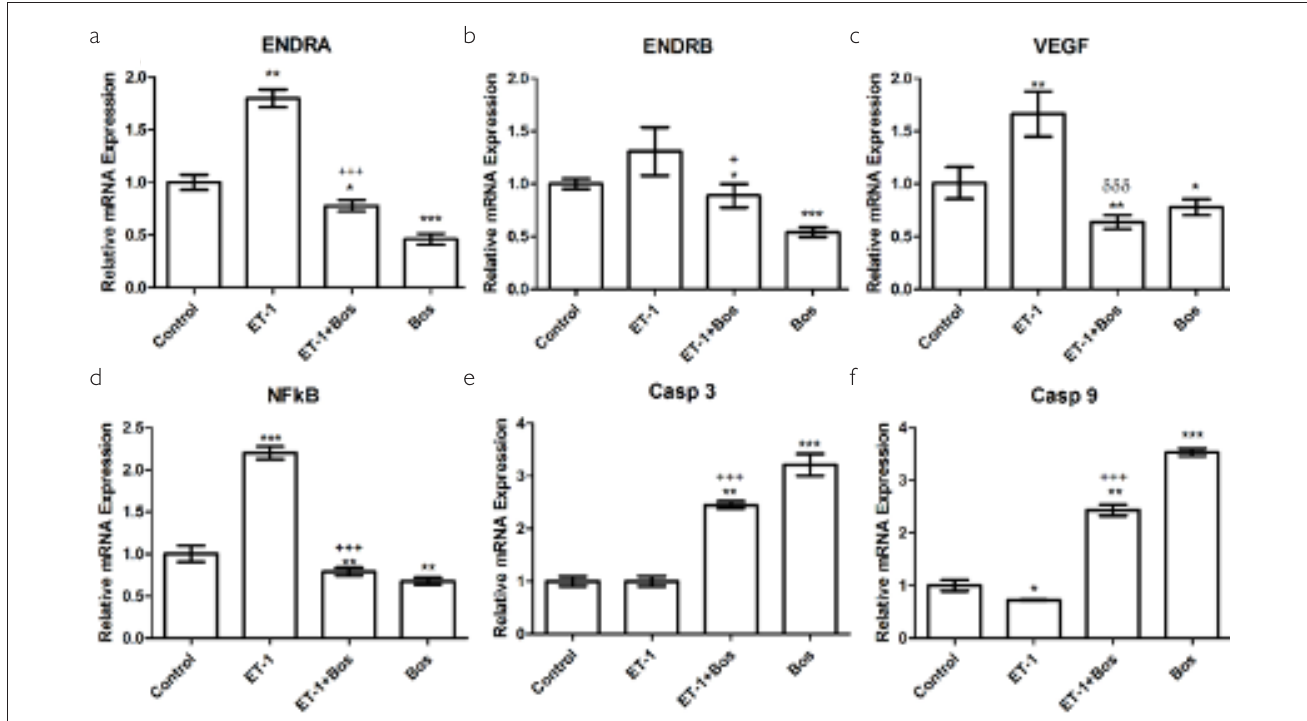
Figure 3. a-f. Effects of ET-1 and bosentan 6 hours after (a) ETRA, (b) ETRB, (c) VEGF, (d) NF-kB, (e) Cas3 and (f) Cas9 mRNA expressions of BC. Columns are shown as mean±SD, (*p<0.05, **p<0.01,